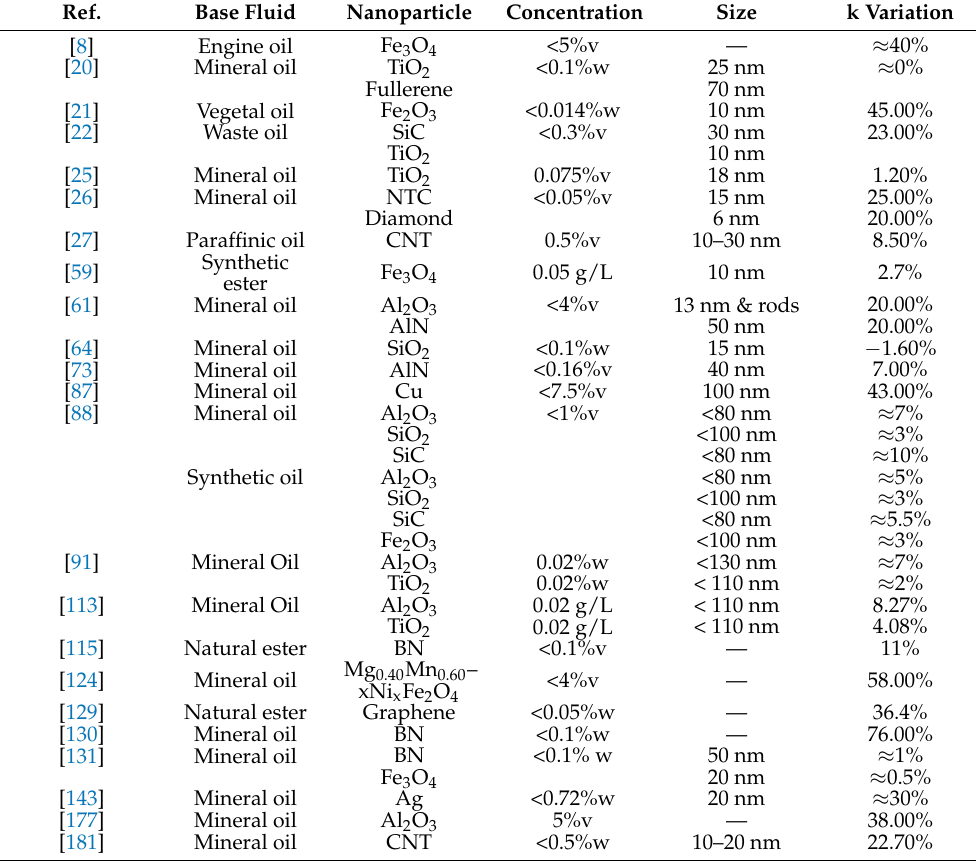
Table 14. Nanofluids characteristics and their effects on thermal conductivity of base fluids.